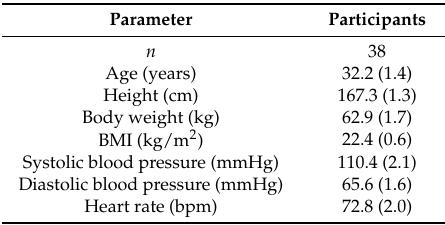
Figure 2. Flow diagram of the progress through the study. Table 2. Baseline characteristics of the participants for evaluation of primary